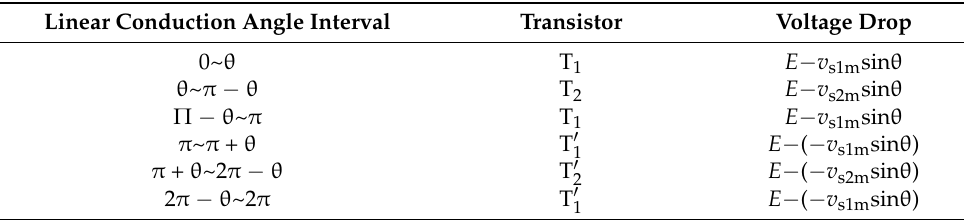
Table 2. Timing list of transistor turn-on linearly.